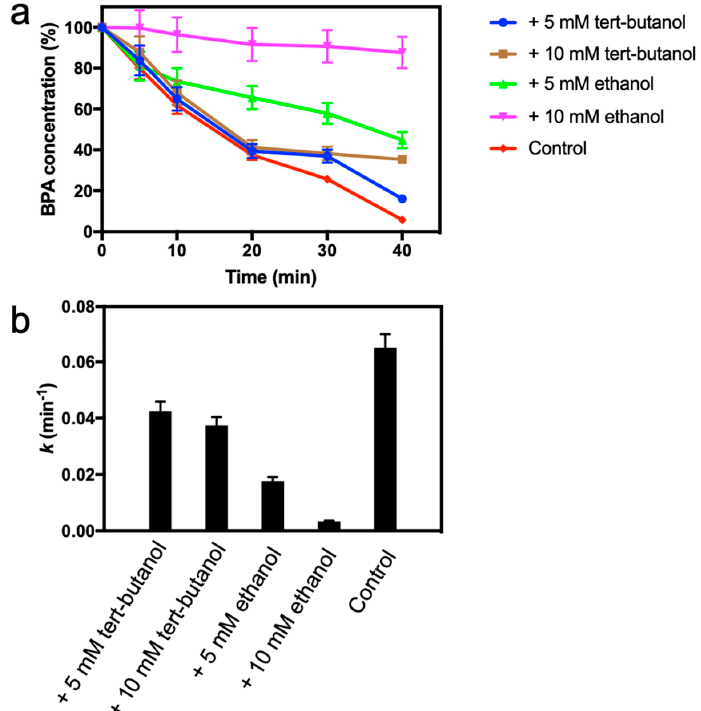
Figure 6. Radical-scavenging assay of the electro/Mn(II)/sulfite process. ( a ) BPA removal and ( b ) pseudo first-order removal constant after addition of radical scavengers. Reaction conditions: 0.2 mM Mn(II), 2 mM sulfite, 5 mM sulfate as supporting electrolyte, 10 μ M BPA, 100 mA electric current, and pH 6. Ethanol and tert -butanol at indicated concentration was added to reaction solution. Control indicates no addition of radical scavenger.